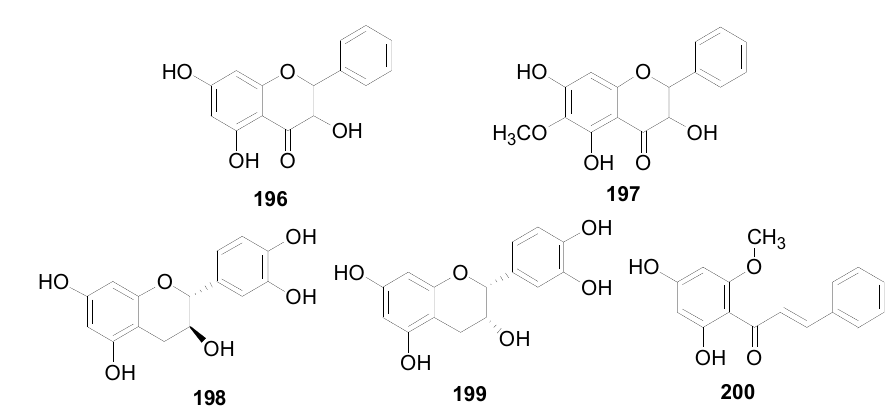
Figure 8. Structures of compounds 196 – 200 .